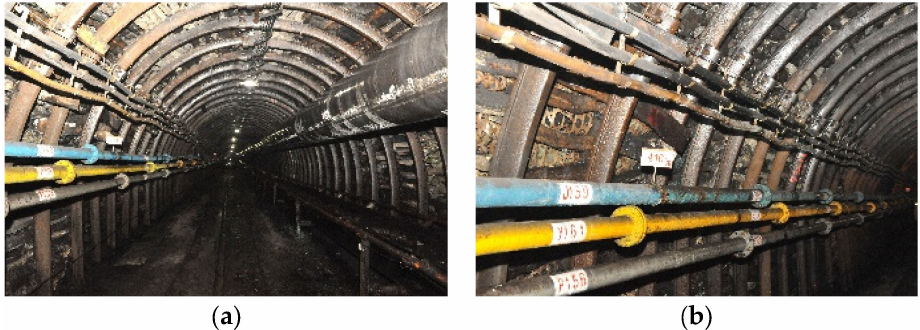
Figure 18. Field roadway support effect. ( a ) Overall effect. ( b ) Local